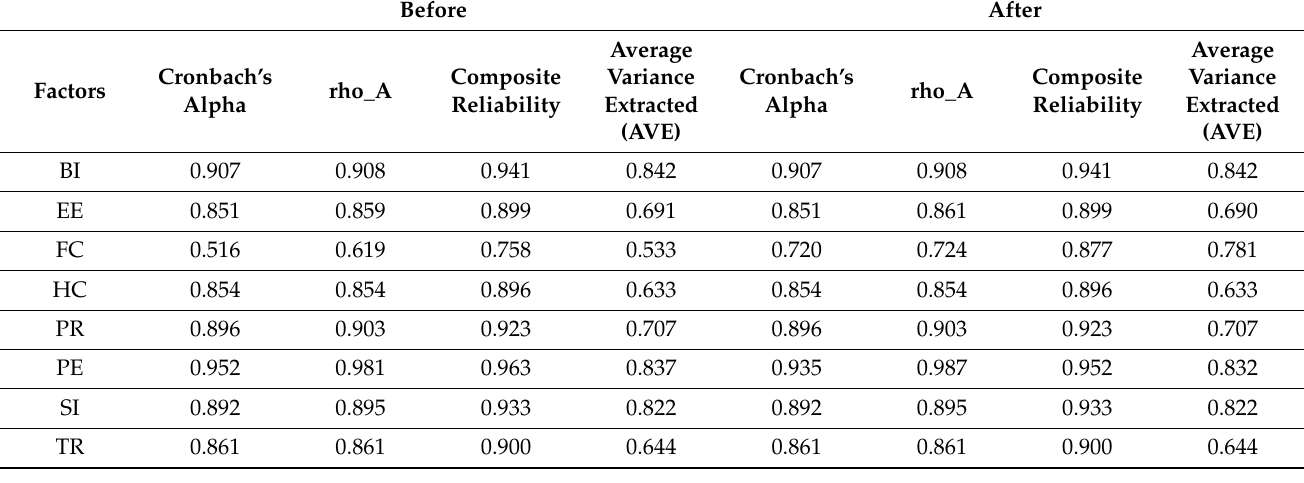
Table 4. Validity and reliability tests.